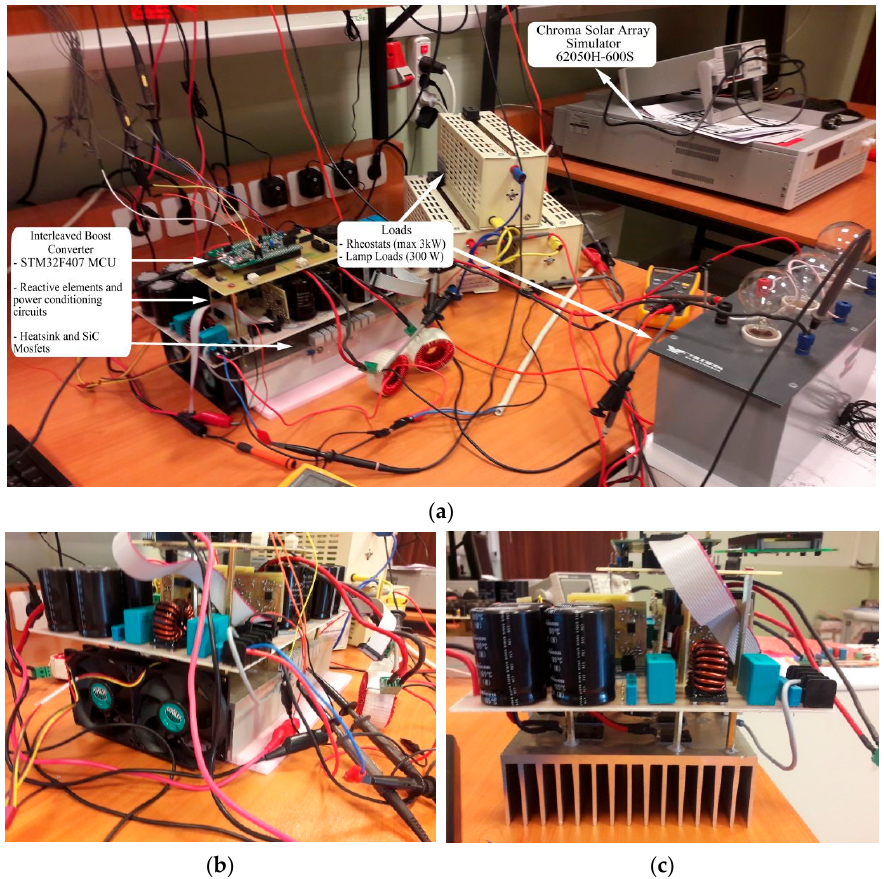
Figure 11. Experimental test setup of two − phase IBC: ( a ) solar array simulator, IBC and loads; ( b , c ) side views of IBC power block.